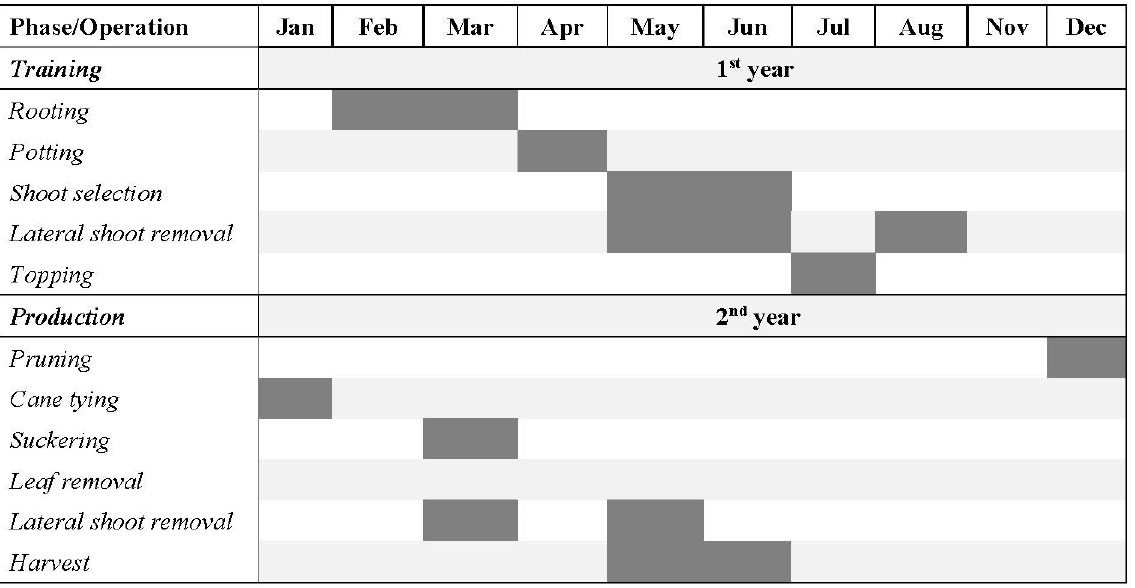
Figure 10. Operational schematic representation of the TGSC plant training and production phases.